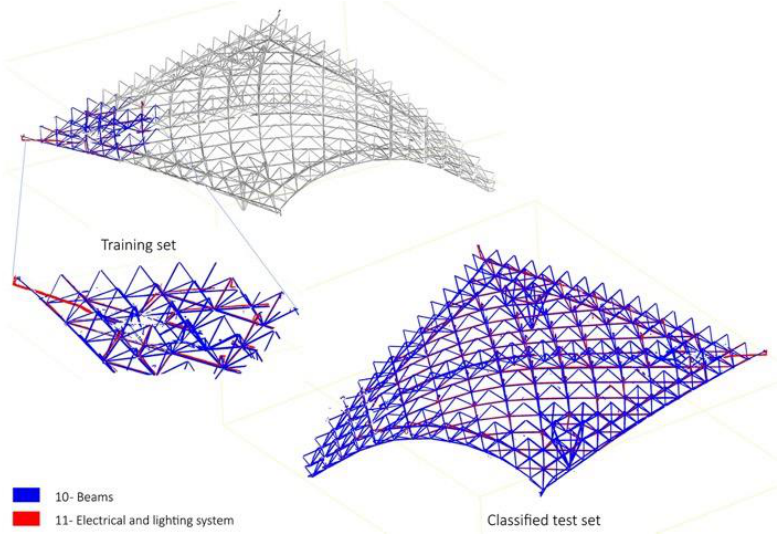
Figure 18. Training set and classification results at the second classification level: Classes 10 and 11.